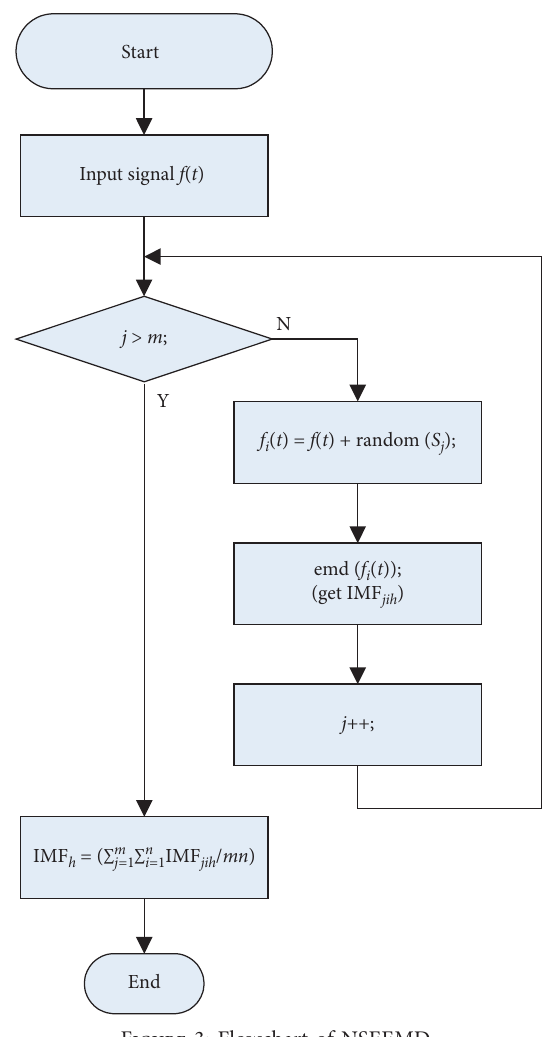
Figure 3: Flowchart of NSEEMD.